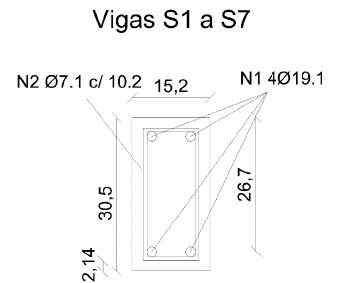
Figure 17: S1 to S7 beams cross section (dimensions in cm and bars diameter in